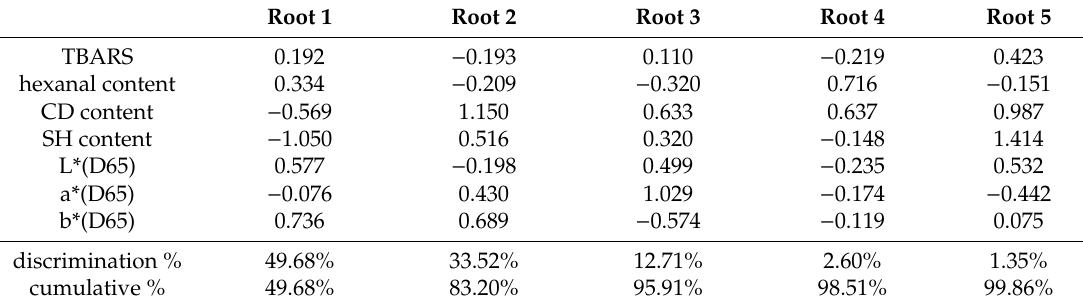
Table 6. Standardized canonical discriminant function coe ffi cients.